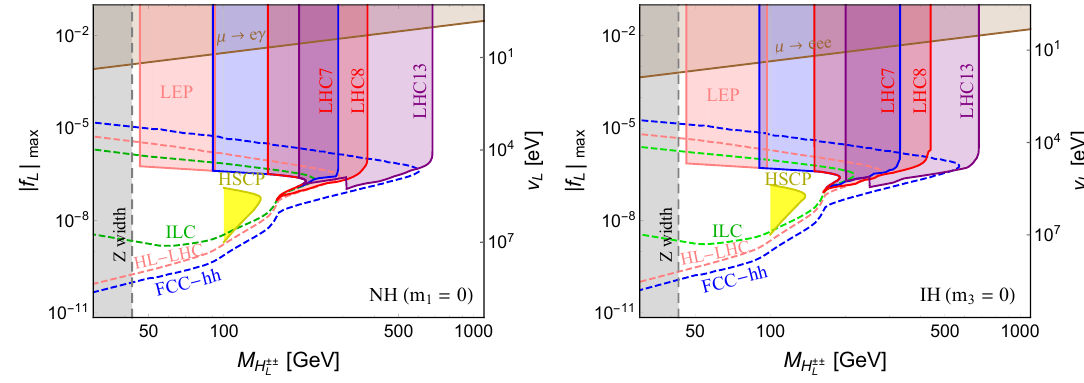
Figure 10 . Summary of the most important constraints and sensitivities on the mass M H (cid:6)(cid:6) L and the Yukawa coupling j f L j max in type-II seesaw, extracted from (cid:12)gures 2, 6, 8 and 9. The corresponding values of the VEV v L are also shown in these plots. The DV prospects at ILC 1 TeV with a luminosity of 1 ab (cid:0) 1 (dashed green), HL-LHC 14 TeV and 3000 fb (cid:0) 1 (dashed pink) and FCC-hh 100 TeV and 30 ab (cid:0) 1 (dashed blue) are shown assuming at least 100 signal events. The left and right panels are respectively for the NH and IH cases, both with the lightest neutrino mass m 0 = 0. All the shaded regions are excluded, which are derived from a combination of the LFV (cid:22) ! e(cid:13) ( (cid:22) ! eee ) limit (brown), the dilepton constraints from LEP (pink), LHC 7 TeV (blue), 8 TeV (red) and 13 TeV (purple), limit on M from Z boson width (gray), and the CMS HSCP H (cid:6)(cid:6) L limit (bright yellow). For all the dilepton limits at LEP and LHC, we have left out the regions with c(cid:28) 0 ( H (cid:6)(cid:6) ) > 0 : 1 mm (cf. (cid:12)gure 6). L